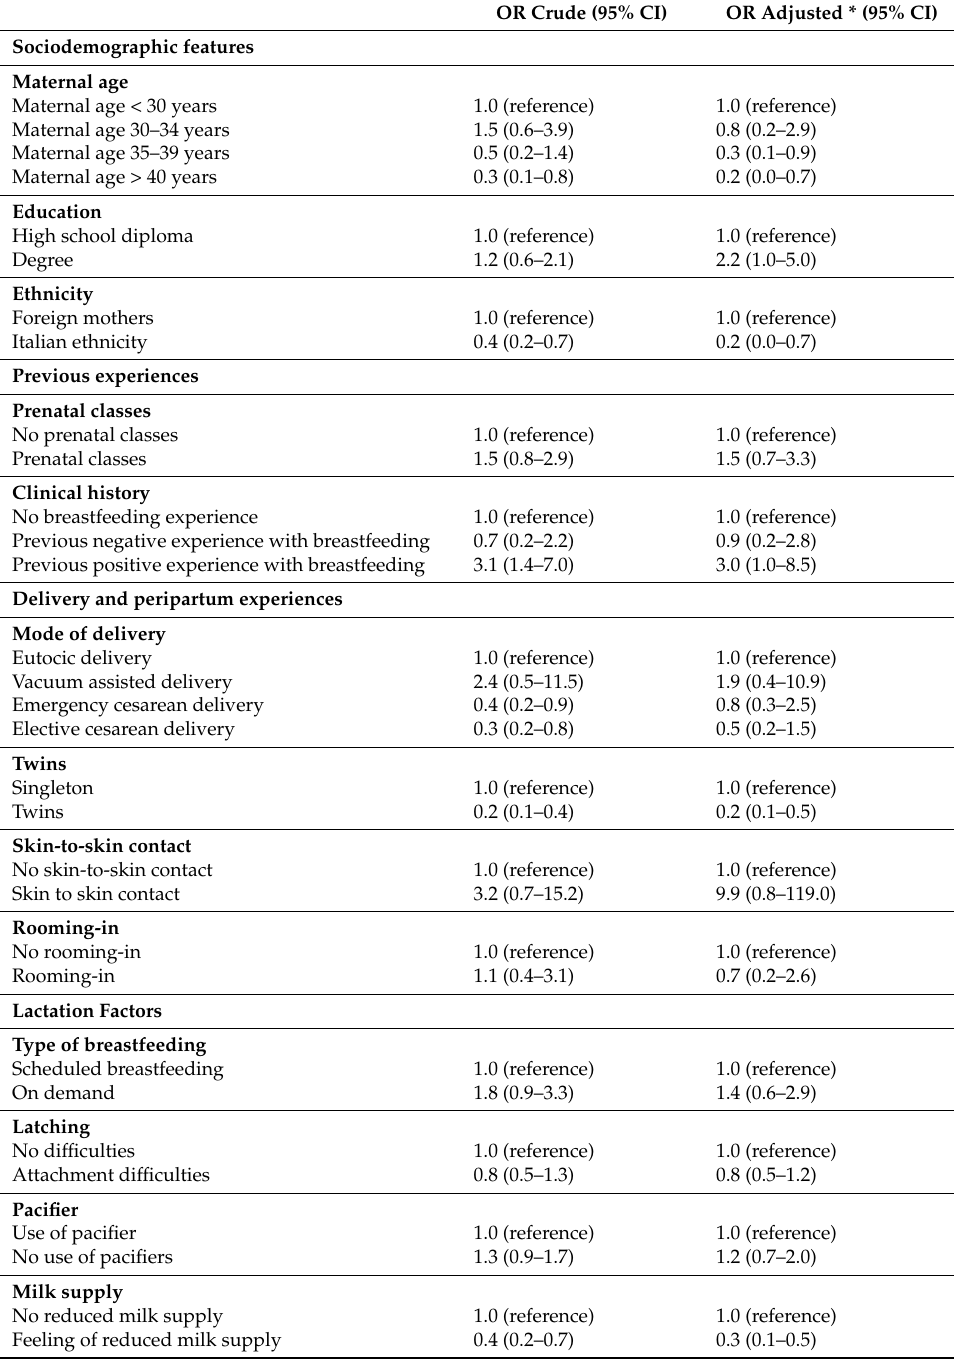
Table 3. Factors affecting breastfeeding: results of univariate and multivariate logistic regressions. OR Crude (95% CI) OR Adjusted * (95%